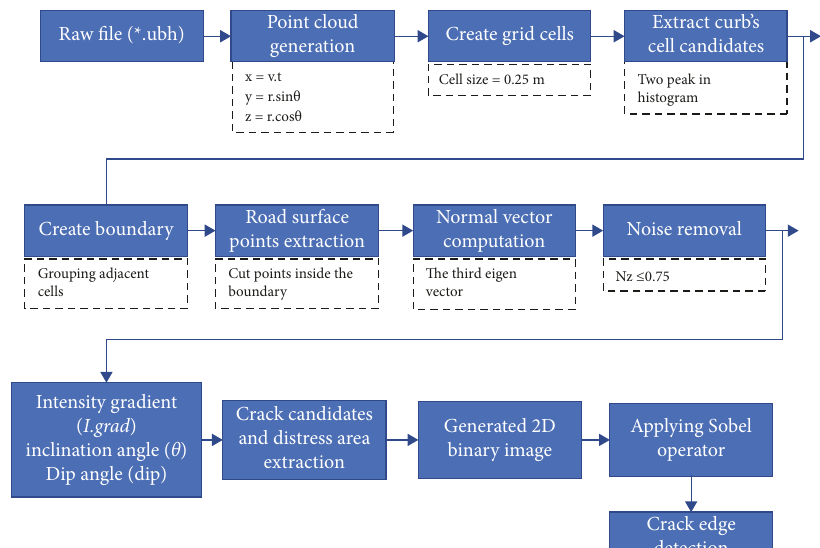
Figure 3: The flowchart of data processing.